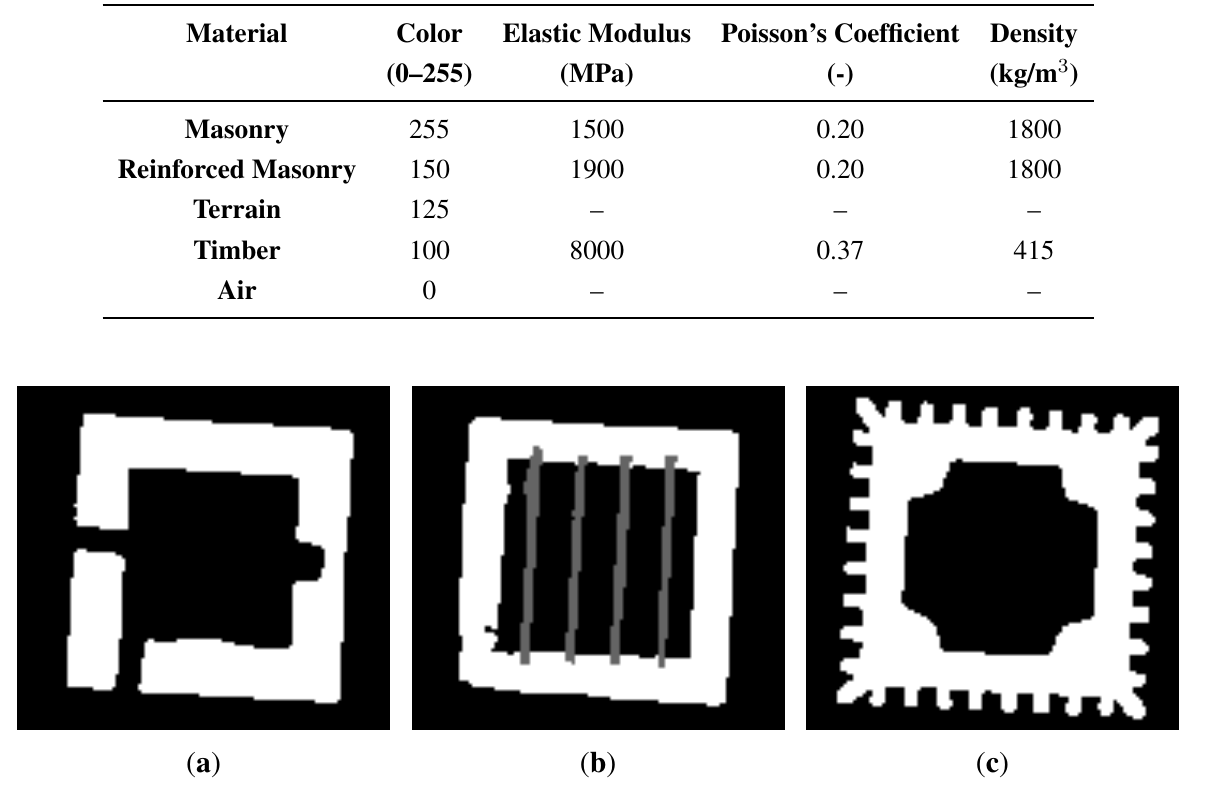
Figure 10. Examples of bitmap slices. ( a ) 42nd slice; ( b ) 84th slice; ( c ) 128th slice. Section along X